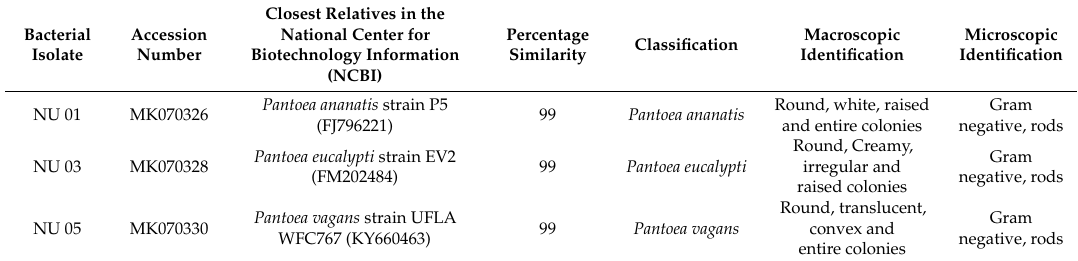
Table 1. Identification of bacterial endophytes from the stems of Solanum